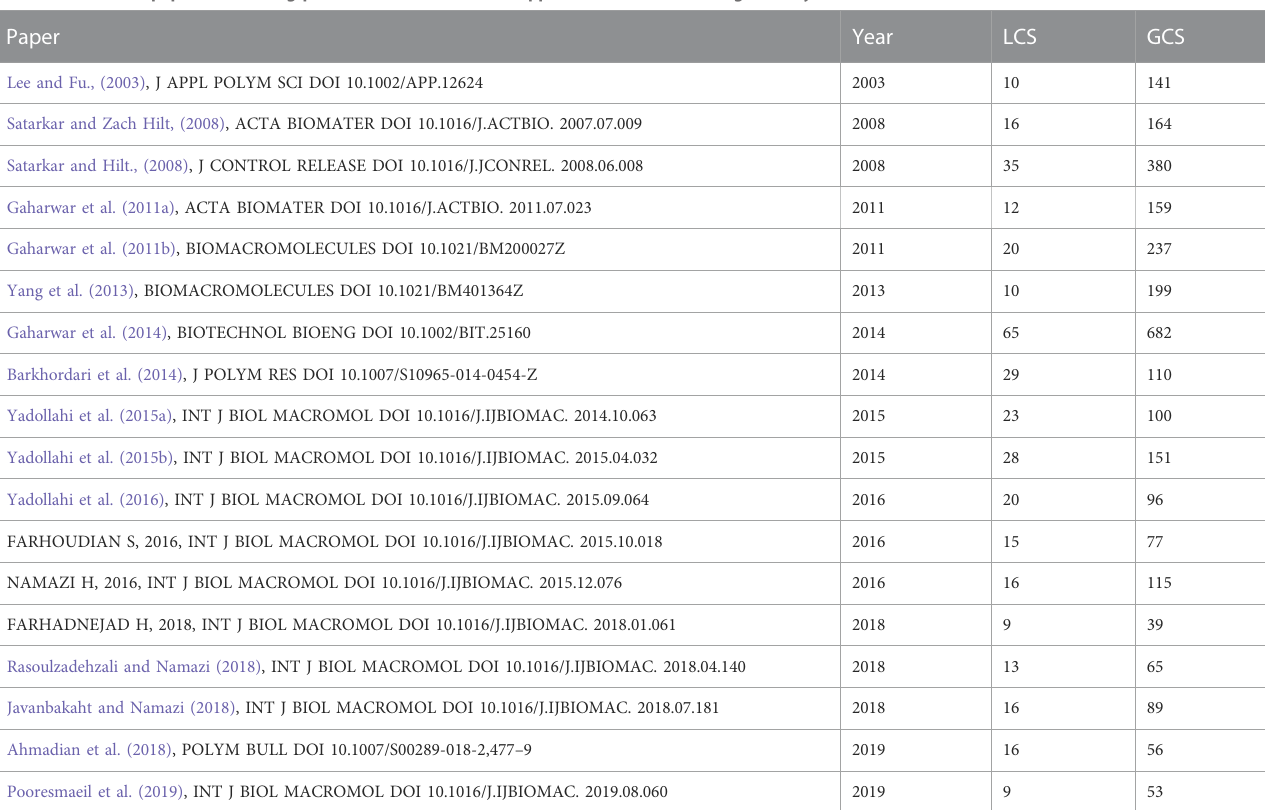
TABLE 4 Landmark papers concerning publications related to the applications of NHs for drug delivery.